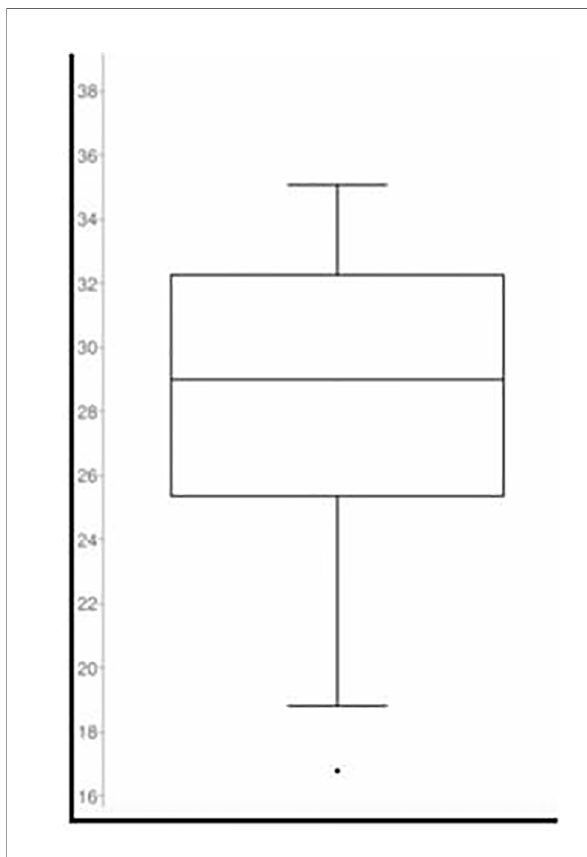
FIGURE 3 | BMI grouping in Box Plot.